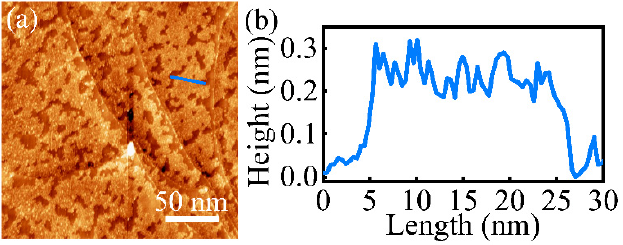
Figure 1. ( a ) STM image of monolayer R6G. The blue line marks the location of the cross-section analysis. ( b ) Corresponding cross-section analysis result for line in ( a ).